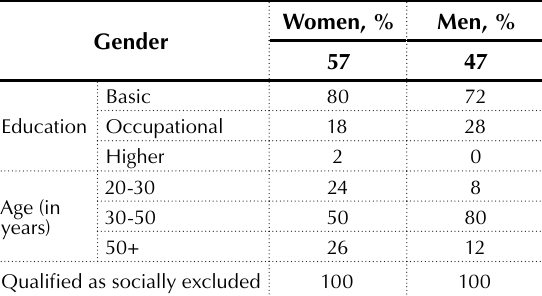
Table 1. Description of the research group Source: Own materials based on own